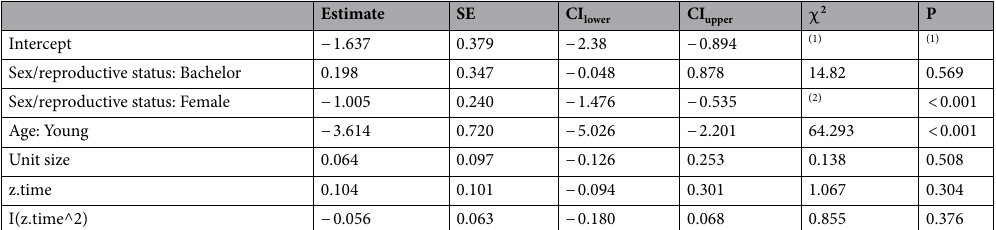
Table 3. Effects of age and sex/reproductive status, as well as unit size, and time of day on the likelihood of attempting to initiate a group departure. Reference category is primary male for sex/reproductive status, and adult for age. Estimated coefficients, standard errors, confidence intervals, and test statistics. (1) not meaningful in this context; (2) equal values because they refer to different terms of the same